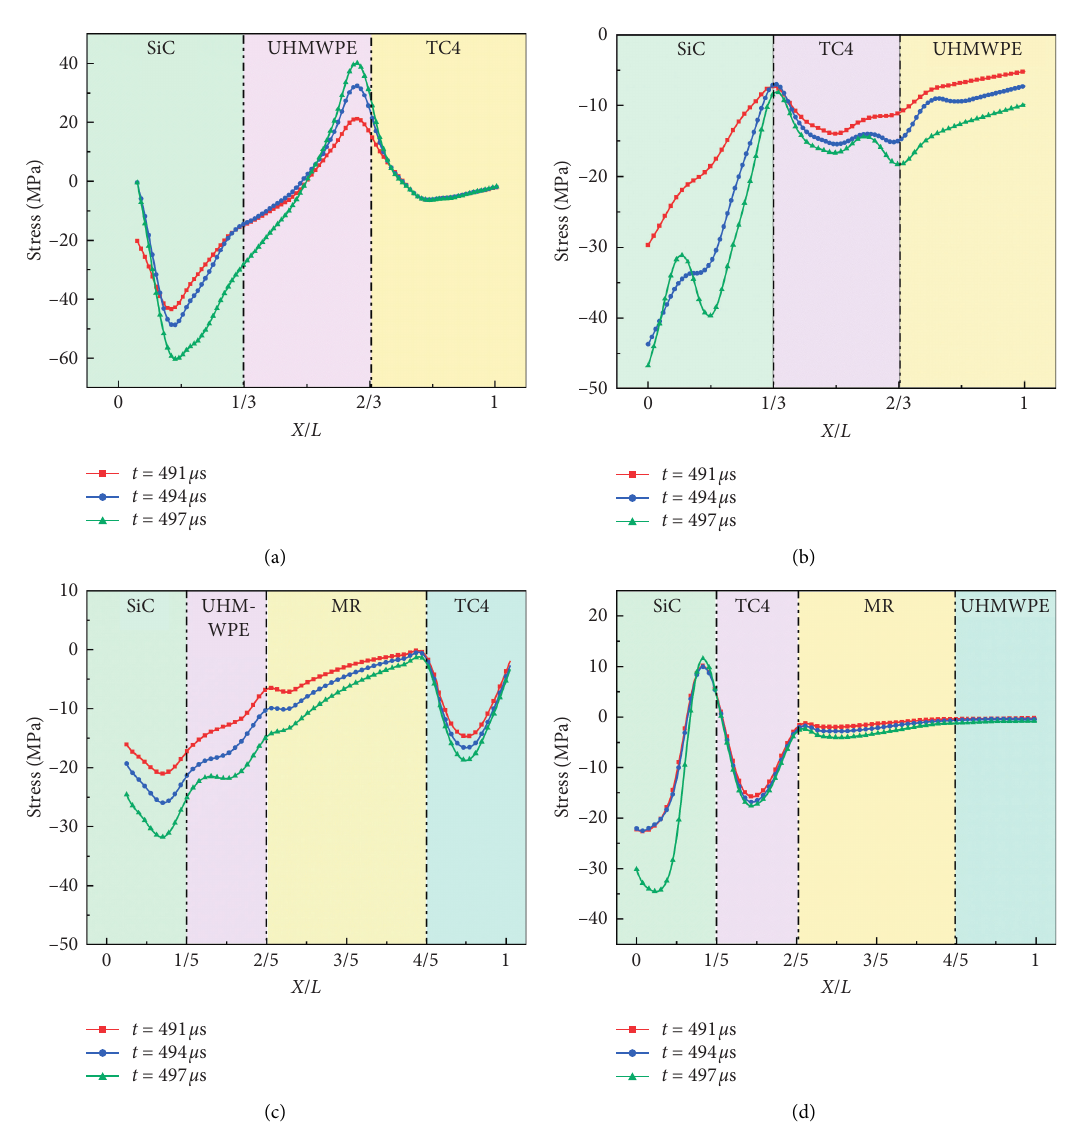
Figure 9: Stress distribution of structure (a) I; (b) II; (c) III; (d) IV.